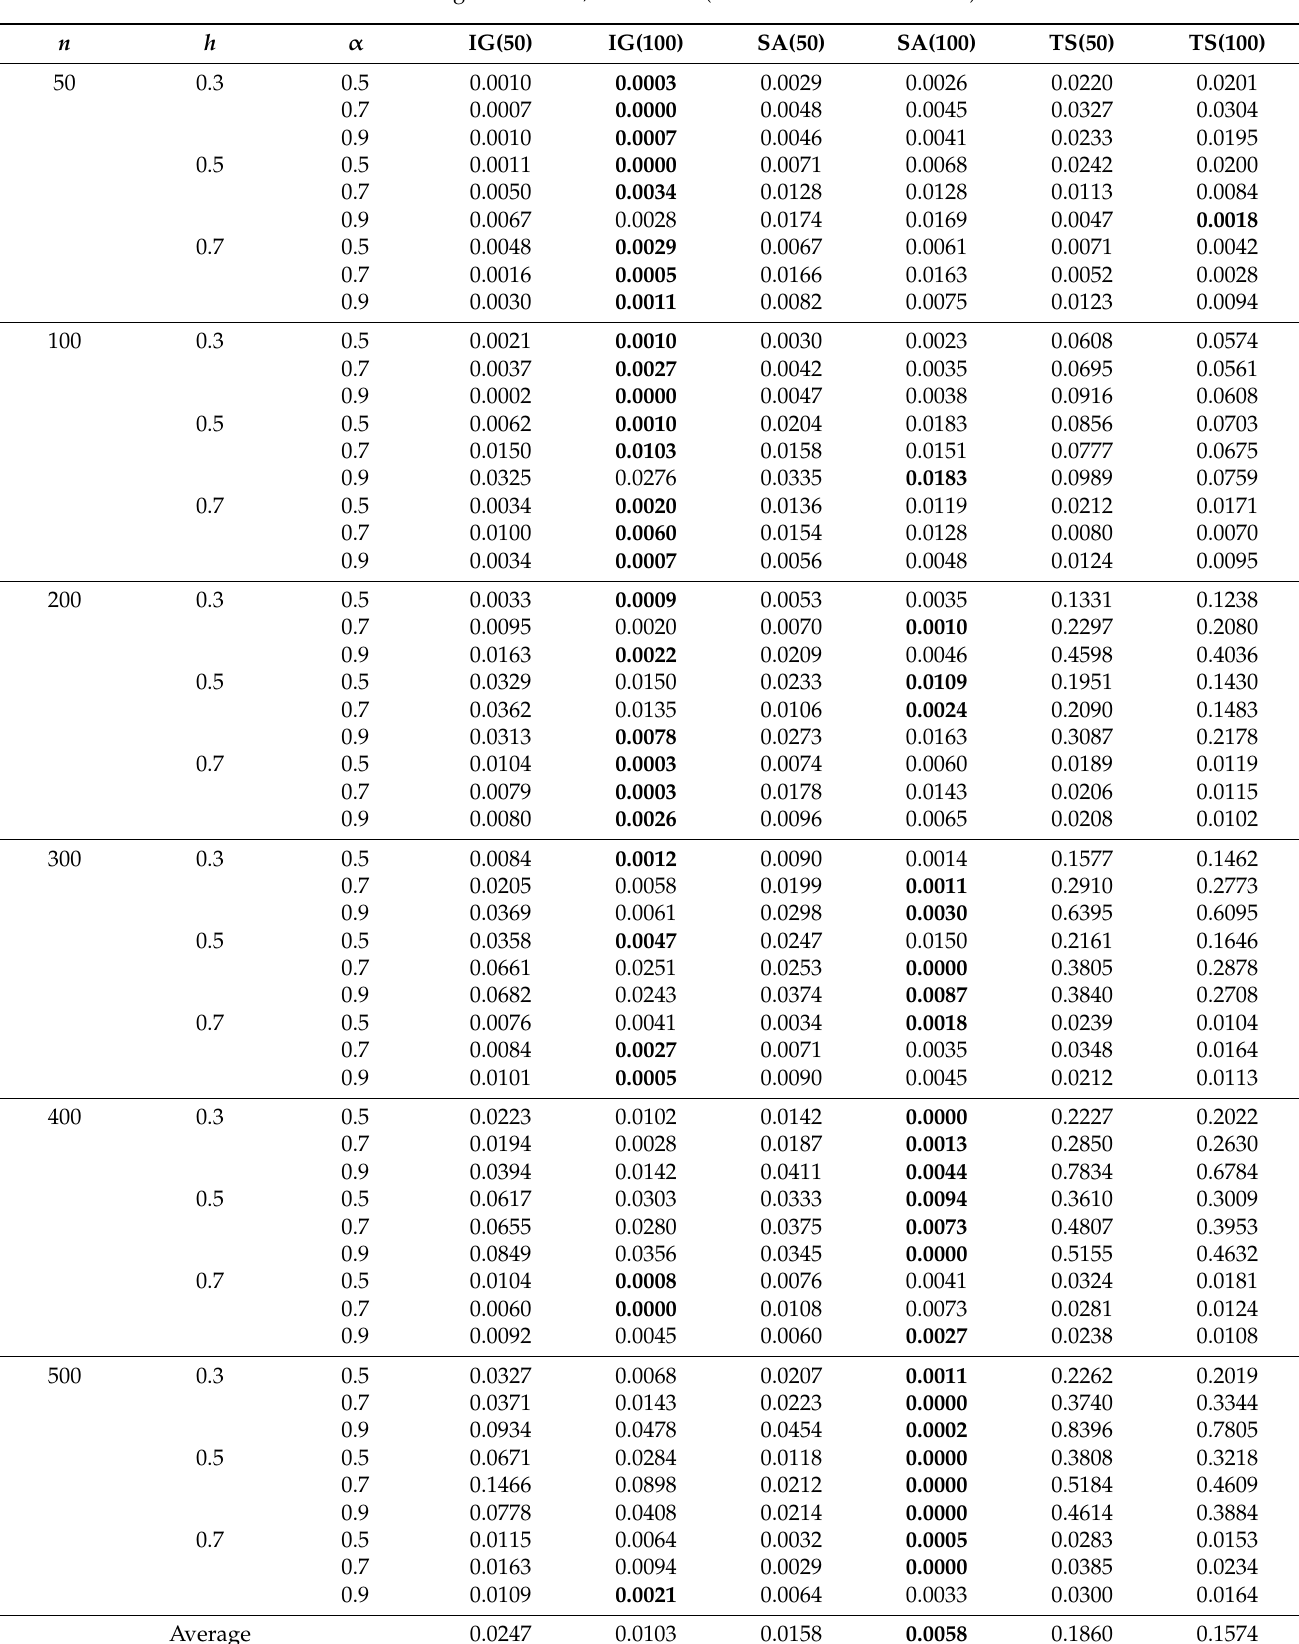
Table 4. Average RPD of IG, SA and TS (the best values are in